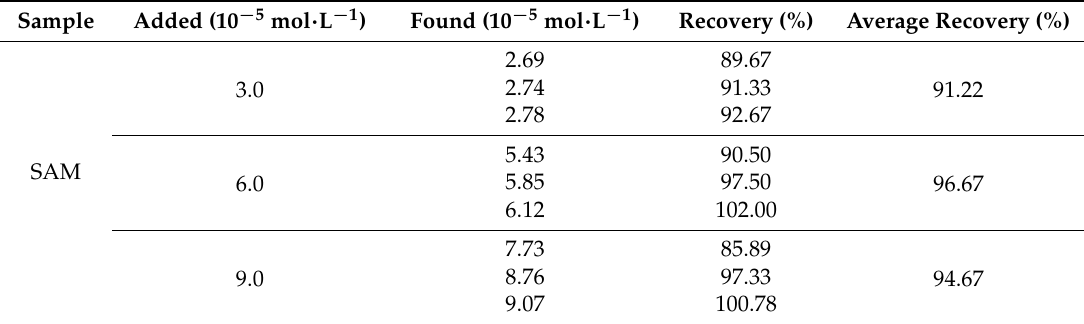
Table 3. Recovery experimental results of the determination of SAM in a real